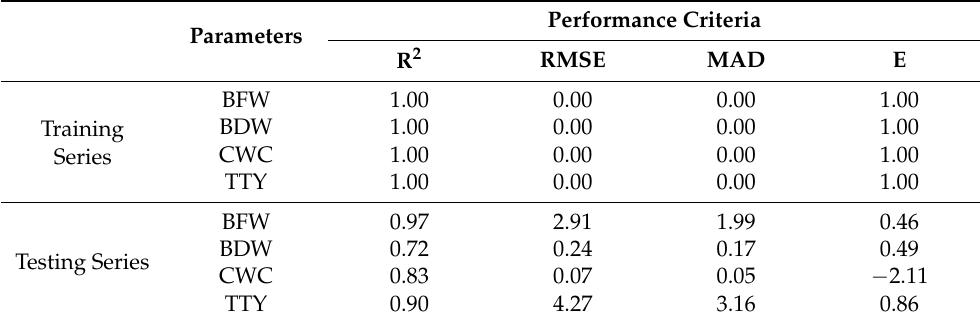
Table 5. Performance criteria of ANFIS models for measured parameters including biomass fresh weight (BFW), biomass dry weight (BDW), canopy water content (CWC), and total tube yield (TTY) of two potato varieties subjected to three irrigation regimes across two growing